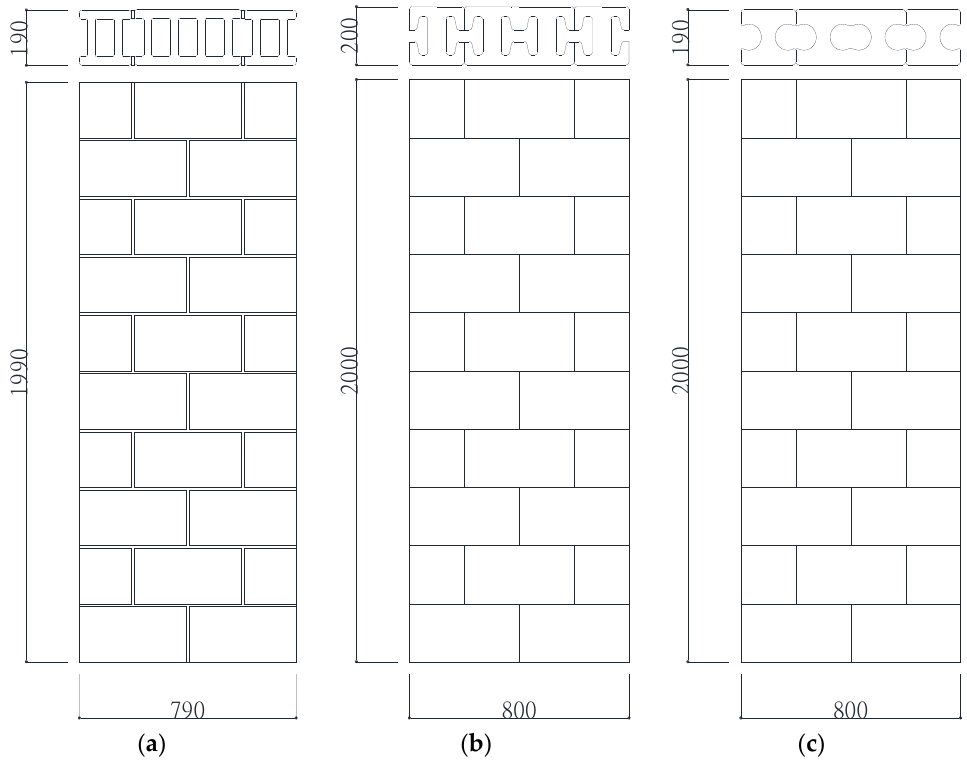
Figure 6. Details of typical and proposed concrete block wall specimens (unit: mm): ( a ) Specimen CB; ( b ) Specimen HS; ( c ) Specimen PS.